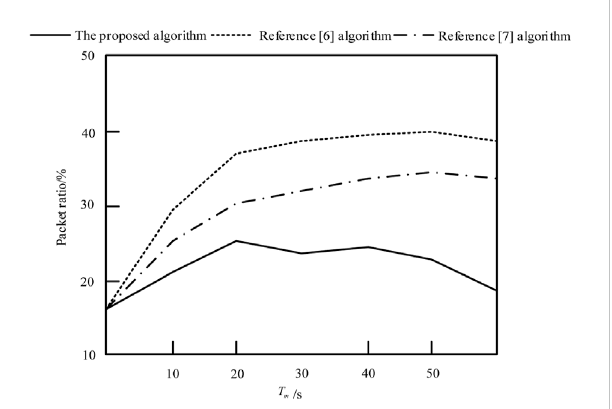
FIGURE 6 Packetratioofmalicious nodestriggered byhackerattack eventsin different